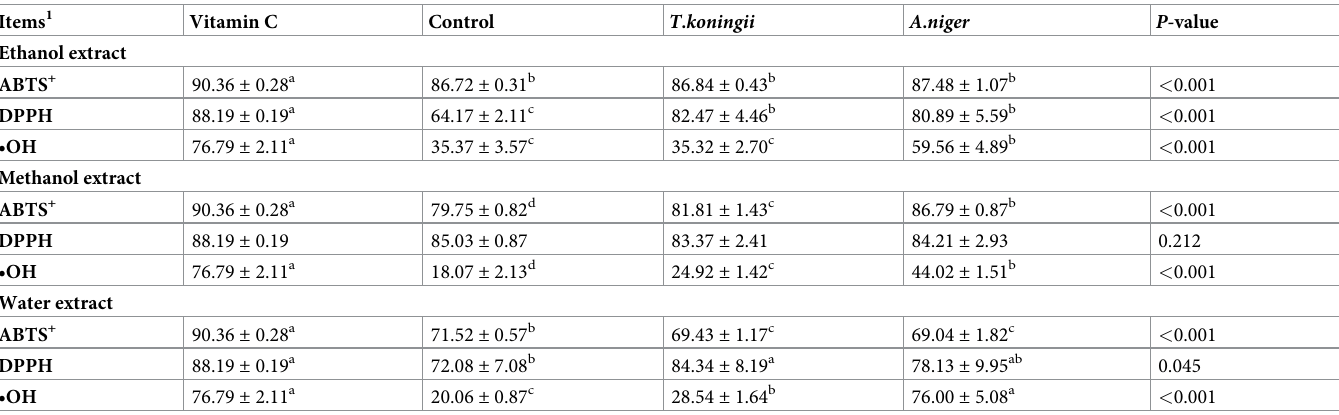
The free radical scavenging ability of all samples was compared with that of vitamin C (Table 3). The DPPH free radical-scavenging ratio of the ethanol extract from FTDs of A . niger and T . koningii was significantly higher than that of the control ( P < 0.05), but it was similar to that of vitamin C ( P > 0.05). In addition, the •OH scavenging ratio of ethanol extract from A . niger FTDs was higher than that of the control and T . koningii ( P < 0.05) but lower than that of vitamin C ( P < 0.05). The highest scavenging ratio of ABST + and •OH was that of vitamin C, followed by those of the methanol extracts of A . niger , T . koningii , and control TDs. The radi- cal-scavenging ratio of vitamin C to ABST + was higher than that of water extract from FTDs Table 3. Free radical scavenging activity (%) of different solvent extracts from fermented tea dregs. Items